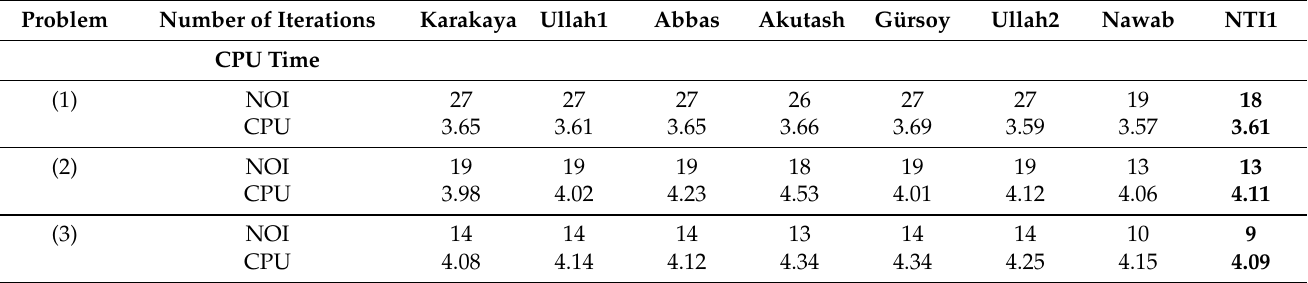
Table 9. Results of comparison of three-step methods for system of